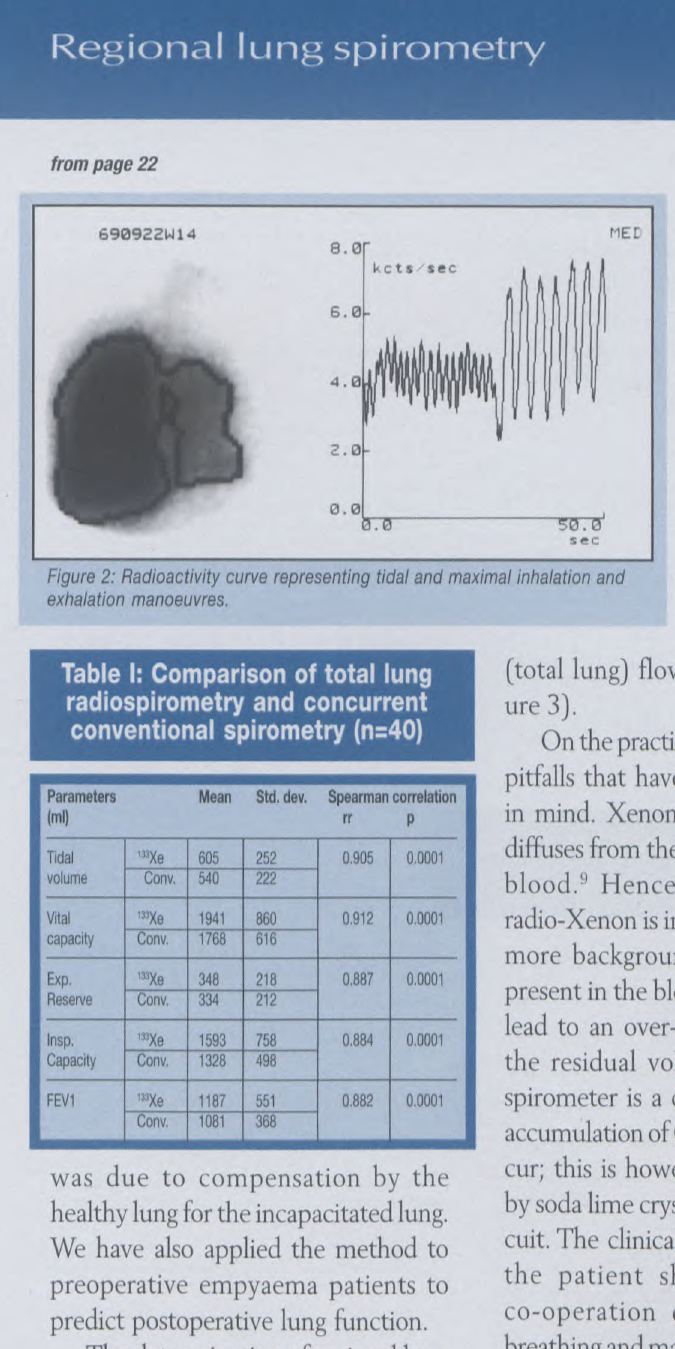
Table I: Comparison of total lung radiospirometry and